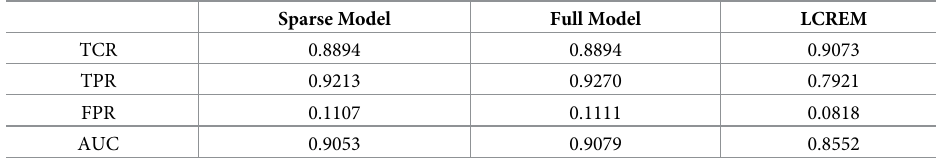
Table 8. Predictive results for the Twitter ego-network.